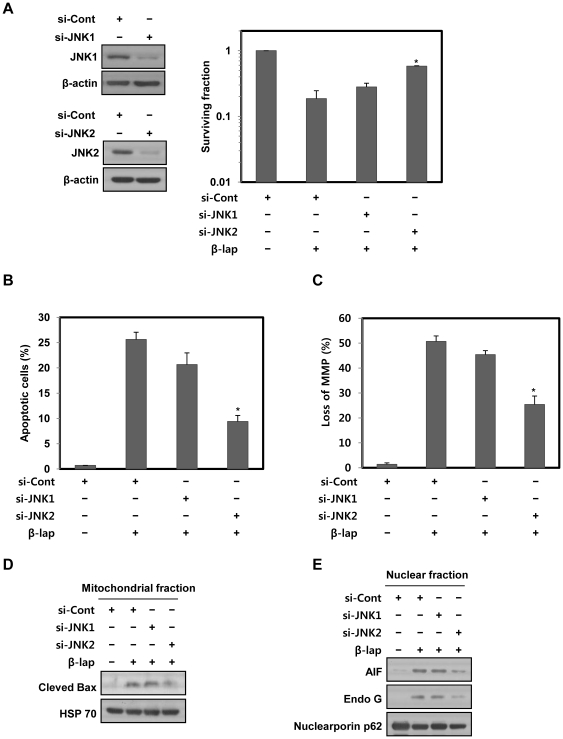
The activity of JNK2 is necessarily required for mitochondria-mediated cell death caused by β-lap.(A) NQO1+-MDA-MB-231 cells transfected with JNK1 or JNK2 siRNA were treated with 5 µM of β-lap. Cells were allowed to grow for 10 to 14 days and were stained with 0.5% crystal violet and scored for colony formation. Results from three independent experiments are expressed as means ± SEM. *Significant difference between si-cont RNA- and si-JNK2 RNA-transfected cells after β-lap treatment, at p<0.05. (B) NQO1+-MDA-MB-231 cells transfected with JNK1 or JNK2 siRNA were treated with 5 µM of β-lap for 18 h. Cells were stained with PI and the percentage of cells with a sub-G1 DNA content was measured via flow cytometric analysis. Results from three independent experiments are expressed as the means ± SEM. *Significant difference between si-cont RNA- and si-JNK2 RNA-transfected cells after β-lap treatment, at p<0.05. (C) NQO1+-MDA-MB-231 cells transfected with JNK1 or JNK2 siRNA were treated with 5 µM of β-lap for 6 h. Cells were loaded with 30 nM of DiOC6(3) for a further 30 min of the treatments. After removal of medium, the concentration of retained DiOC6(3) was measured by flow cytometry. Results from three independent experiments are expressed as means ± SEMs. *Significant difference between si-cont RNA- and si-JNK2 RNA-transfected cells after β-lap treatment, at p<0.05. (D) NQO1+-MDA-MB-231 cells transfected with JNK1 or JNK2 siRNA were treated with 5 µM of β-lap for 6 h. Mitochondrial fractions were prepared and subjected to Western blot analysis using anti-Bax and -mitochondrial HSP70 antibodies. Mitochondrial HSP70 was used as a mitochondrial marker protein. The data are representative a typical experiment conducted three times. (E) NQO1+-MDA-MB-231 cells transfected with JNK1 or JNK2 siRNA were treated with 5 µM of β-lap for 6 h. Nuclear fractions were prepared and subjected to Western blot analysis using anti-AIF, -Endo G, and -Nucleoporin p62 antibodies. Nucleoporin p62 was used as a nuclear marker protein. The data are representative a typical experiment conducted three times. The data are representative of a typical experiment conducted three times with similar results.